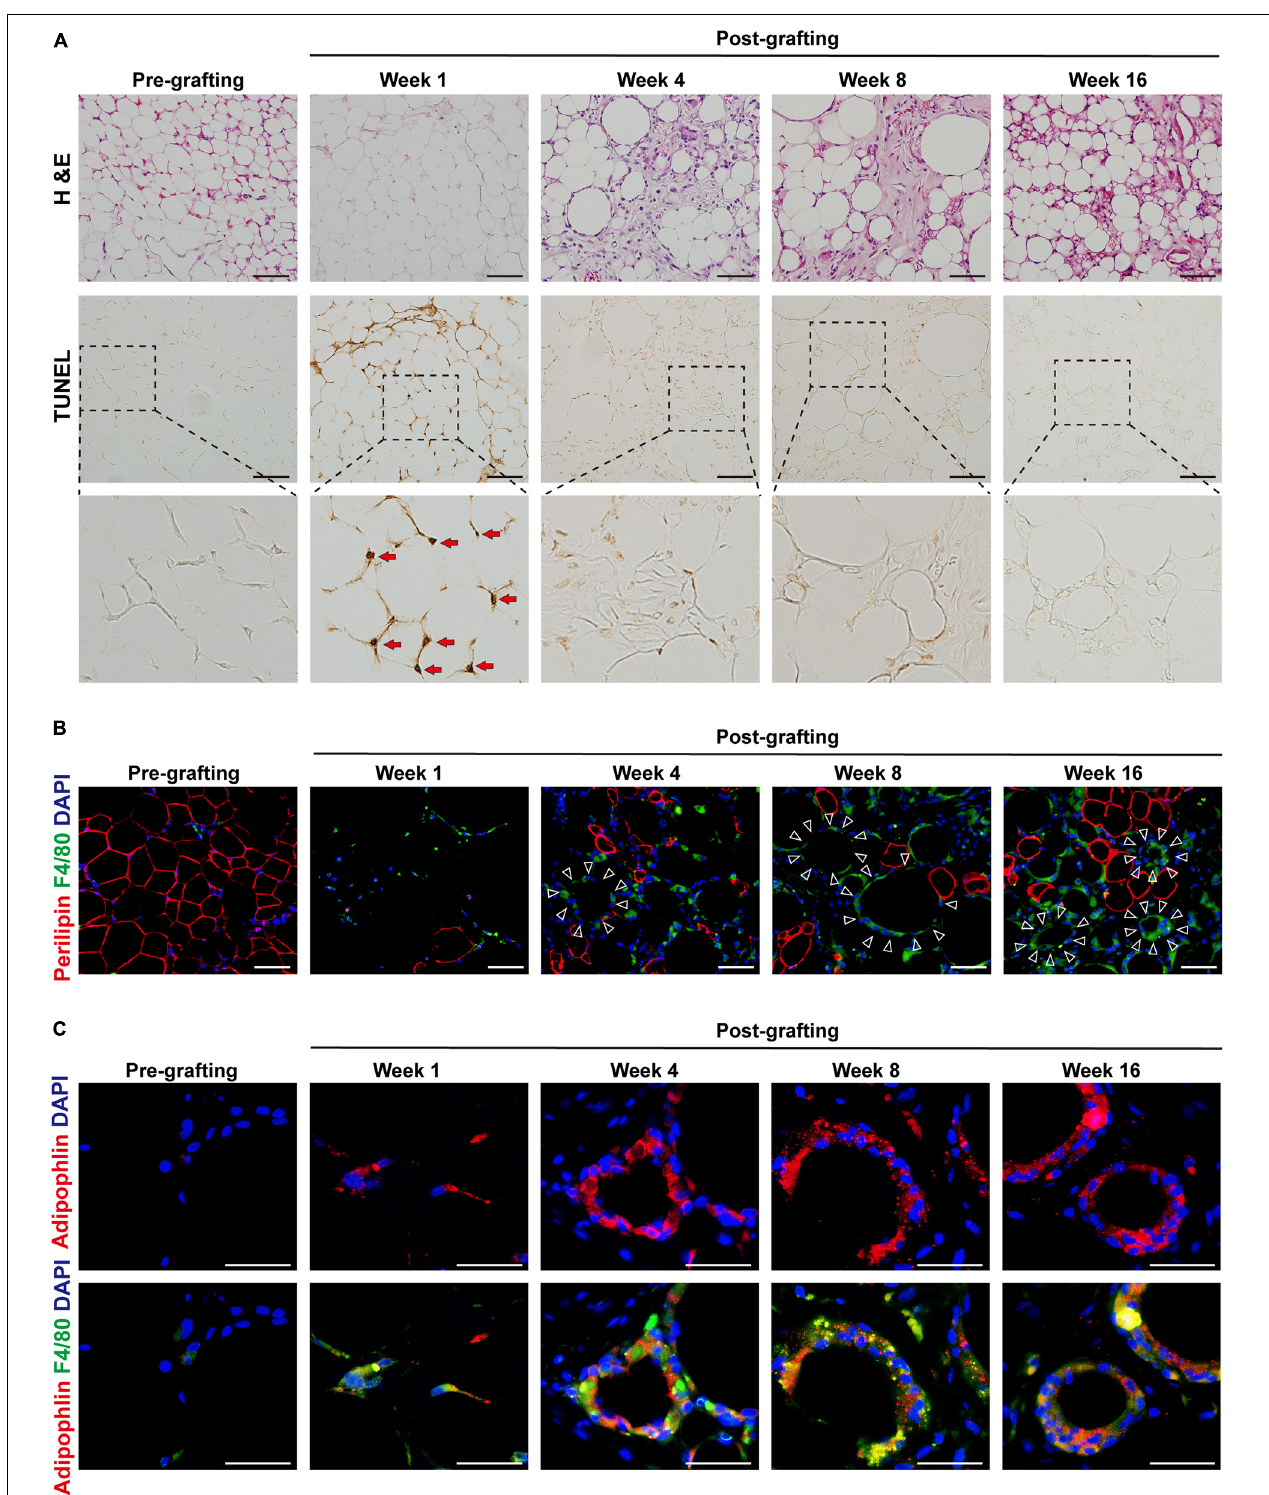
FIGURE 2 | MFCs are formed in crown-like structures (CLSs) in fibrotic regions of fat graft tissue. (A) Representative H&E and TUNEL staining of fat tissue before and after grafting. Red arrows indicate the apoptotic adipocytes. (B) Representative immunofluorescence staining of perilipin (red) and F4/80 (green) in fat tissue before and after grafting. Large oil droplets or apoptotic adipocytes were surrounded by F4/80 + macrophages, forming typical CLSs (triangles). (C) Representative immunofluorescence staining of adipophilin (red) and F4/80 (green) in fat tissue before and after grafting. Scale bars = 50 µ m.